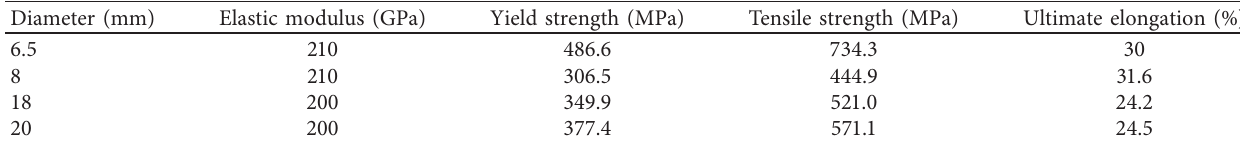
Table 2: Properties of reinforcement.